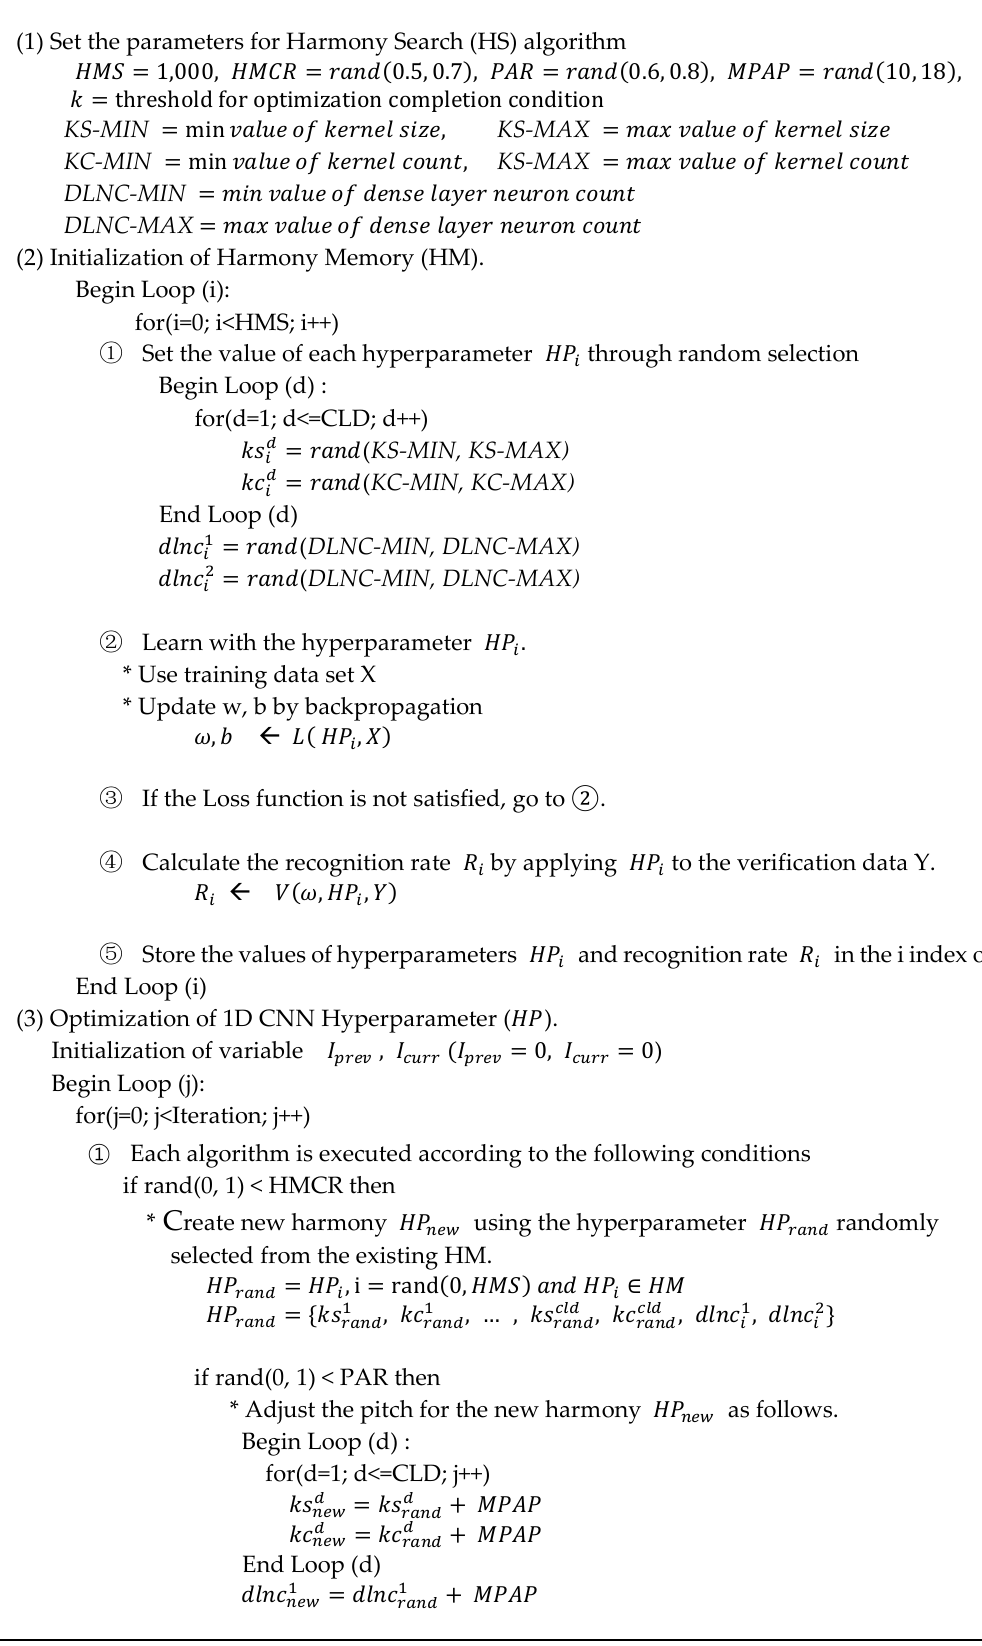
Algorithm 1: Algorithm for Optimizing Hyperparameters of 1D CNN using